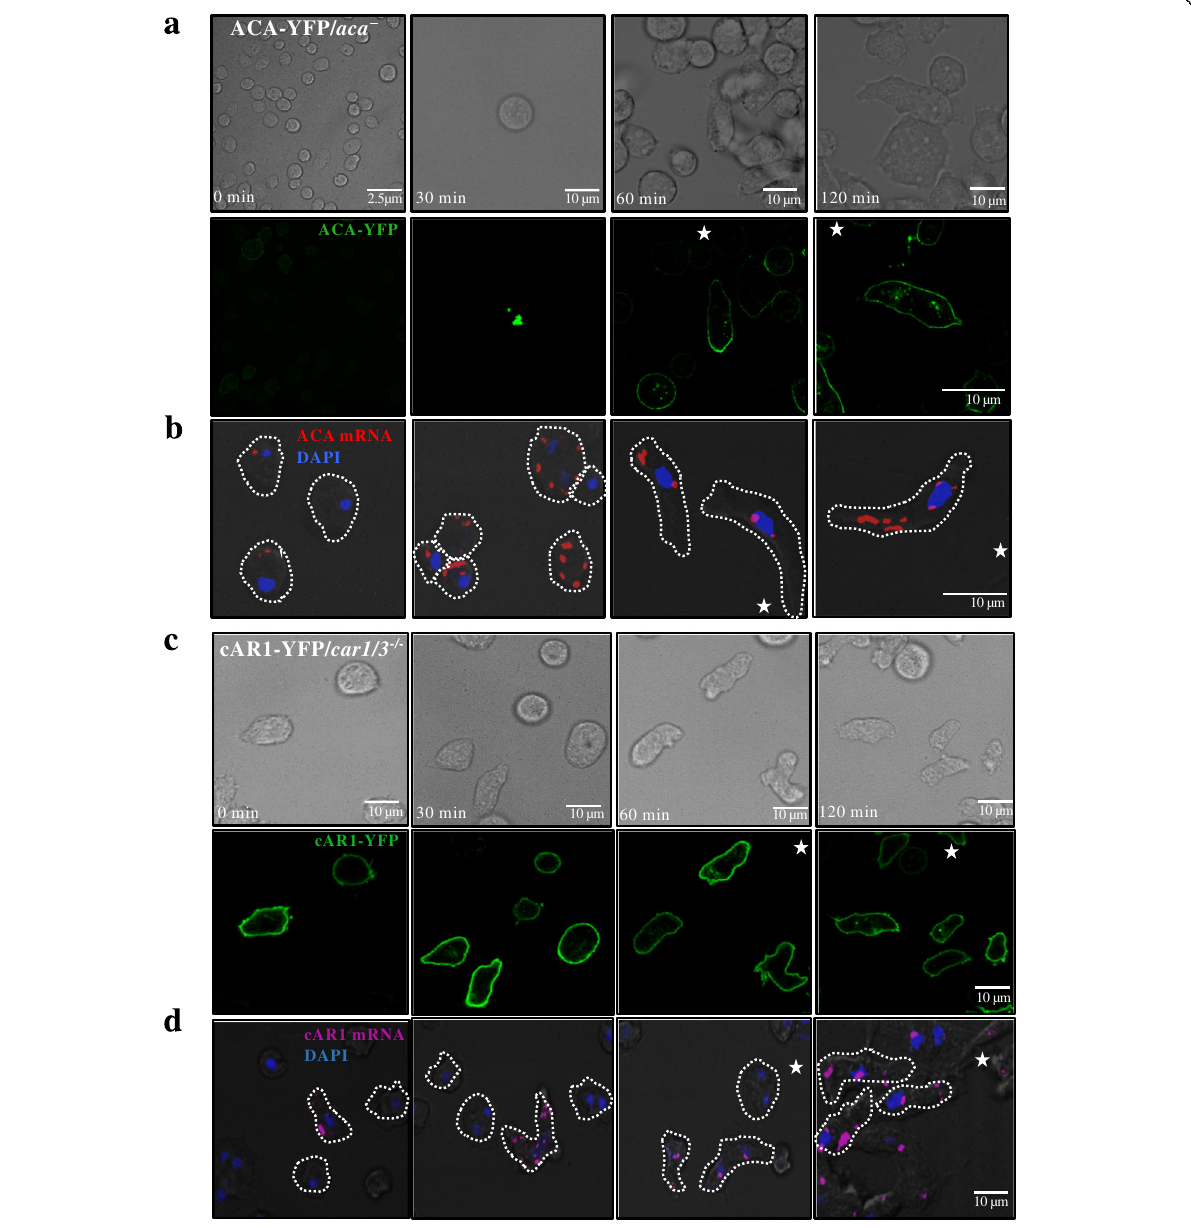
Fig. 3 ACA translation occurs in the cytoplasm followed by localization to the posterior of the polarized cells. a Representative phase contrast ( upper panel ) and confocal fluorescent ( lower panel ) images of ACA-YFP/ aca − cells treated with 1.6 mM CHX for 2 h. Fluorescent recovery was monitored after CHX removal. ACA-YFP protein is depicted in green . The white star indicates the location of the aggregation center. Data are representative of at least 3 independent experiments. b Representative maximum intensity projections of confocal fluorescent images of ACA-YFP/ aca − cells depicting DAPI ( blue ) and ACA mRNA ( red ). The white star indicates the location of the aggregation center. Data are representative of at least 3 independent experiments. c Representative phase contrast ( upper panel ) and confocal fluorescent ( lower panel ) images of cAR1-YFP/ car1/3 − / − treated with 1.6 mM CHX for 2 h. Fluorescent recovery was monitored after CHX removal. cAR1-YFP protein is depicted in green . The white star indicates the location of the aggregation center. Data are representative of at least 3 independent experiments. d Representative maximum intensity projections of confocal fluorescent images depicting DAPI ( blue ) and cAR1 mRNA ( red ). The white star indicates the location of the aggregation center. Data are representative of at least 3 independent ORF and ACA-3 ′ ORF cells (Fig. 4b). However, neither mRNA open reading frame (ORF) (Fig. 4a), in aca − cells. cell lines expressed truncated proteins (data not shown). RT-PCR analyses using specific primers confirmed that The cellular distribution of the deleted ACA mRNAs the expected transcripts were synthesized in the ACA-5 ′